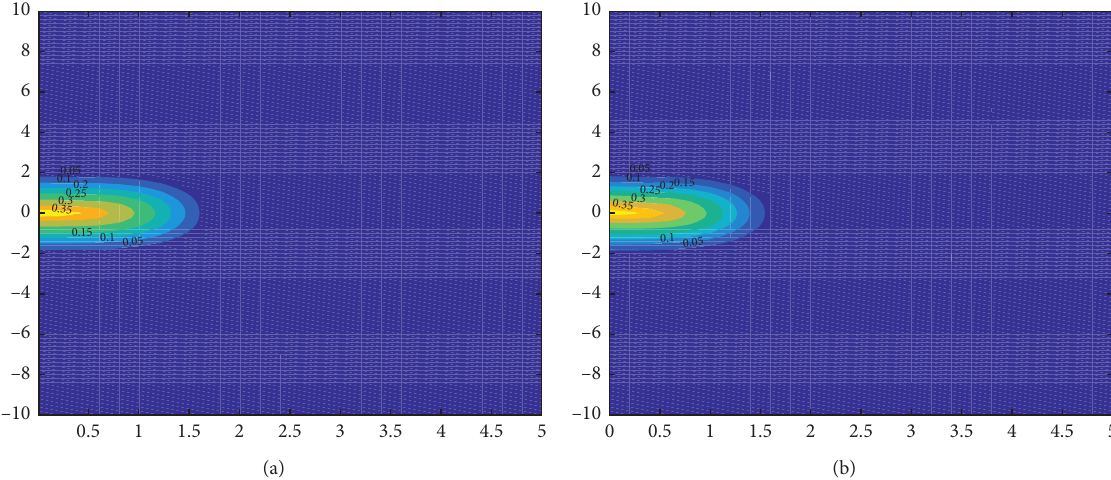
Figure 7: Contour plots of stationary joint PDFs for displacement x results.